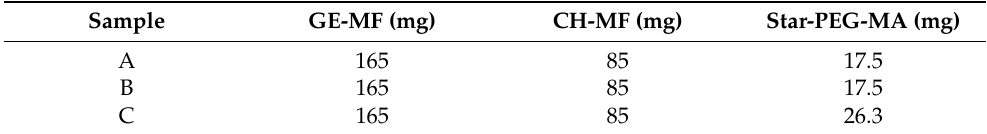
Table 3. Composition of the hydrogel samples prepared for qualitative and quantitative printing performance